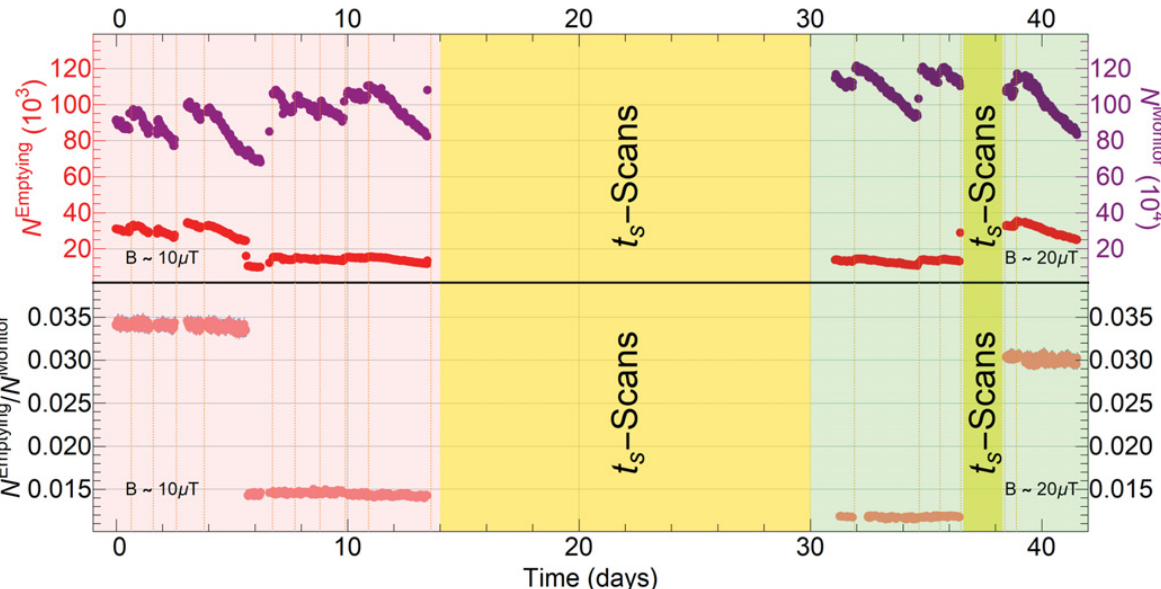
Figure 3. Top : Plot showing UCN monitor counts in purple (in units of ten thousands, corresponding to the vertical axis on the right hand side), and emptying counts in red (in units of thousands, corresponding to the vertical axis on the left hand side), both averaged over a dwell of 4 cycles over the entire data taking stretch of the n − n (cid:1) oscillation search. Bottom : Ratio between the emptying and monitor counts as a function of time, for each dwell of 4 cycles. In both plots, yellow regions labeled - ‘ t s − Scans’ refer to a time period when the stored UCN energy spectra were estimated. The pink regions labeled ‘ B ∼ 10 µ T’ and green regions labeled ‘ B ∼ 20 µ T’ refer to runs which were collected by applying the corresponding indicated magnetic field. The large steps in the normalized counts correspond to switching between the micro-timer storage times, 180s and 380s. The vertical orange dotted lines indicate when the solid deuterium moderator was reconditioned [35], to recover the maximal neutron flux from the UCN